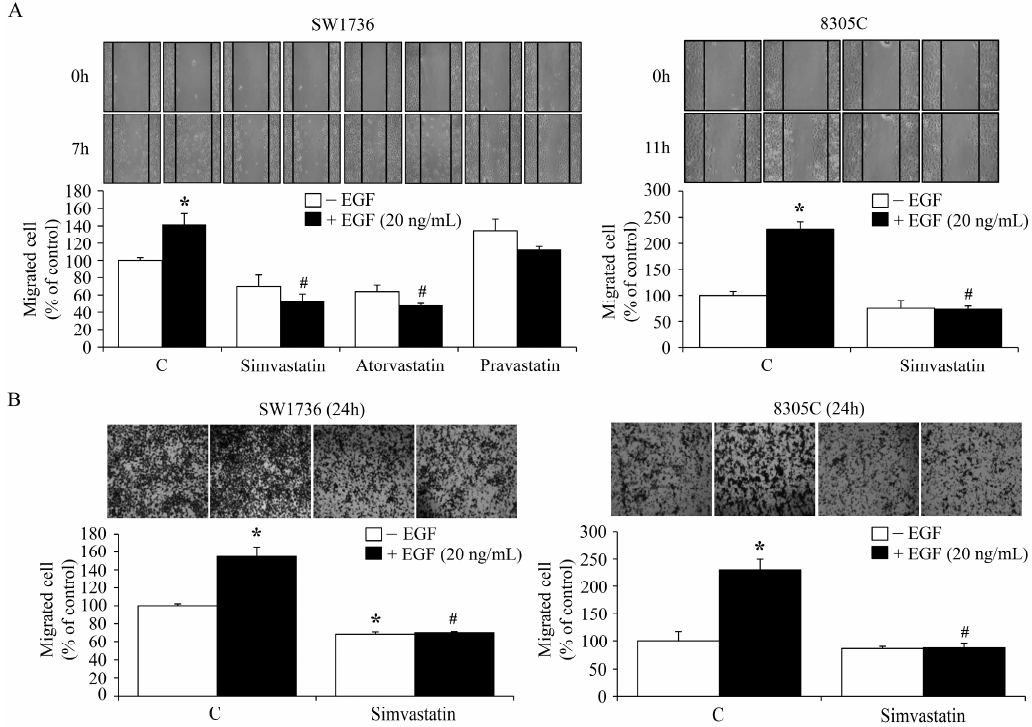
Figure 6. Effects of simvastatin on the EGF-enhanced ATC cell migration. Simvastatin (10 µ M) diminished the migrated cell number of SW1736 and 8305C cells treated with or without EGF and evaluated using scratch assay ( A ) or Transwell assay ( B ). For horizontal cell migration, cells were pre-incubated with simvastatin for 1 h followed by a creation of migration gap and EGF administration in culture medium containing 2% FBS for additional 7 or 11 h. Cells in the migration gap were counted. For vertical cell migration, cells were pre-incubated with simvastatin for 4 h and then seeded into upper chamber of transwells containing 0% FBS. After 24 h the migrated cells attracted by the culture medium containing 5% FBS with or without EGF on the side of lower chamber of Transwell were counted. Values represent the means ± SEM ( n = 3). * p < 0.05, different from corresponding control. # p < 0.05, different from EGF-incubated only group. C, control.